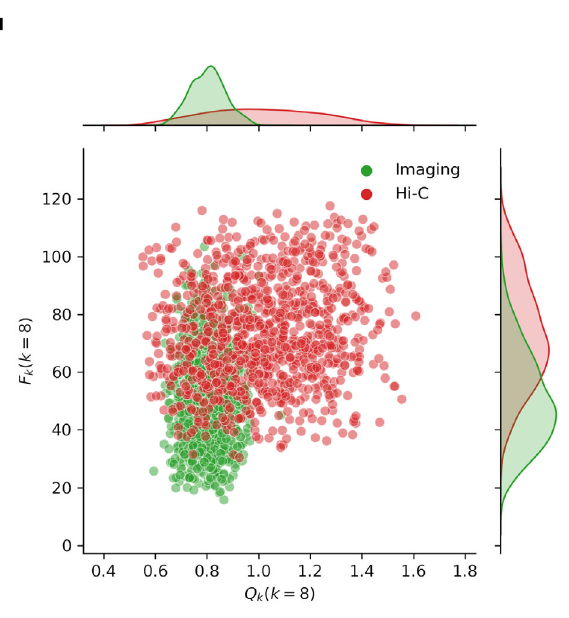
the resulting correlation matrix. d Scatter plot of Q k ( k =8) and F k ( k =8) for 1000 conformations. The conformations are randomly chosen from the total of ~3000 conformations measured in the imaging experiment (green). For Hi-C, 1000 con- formationsarerandomlygeneratedusingHIPPS/DIMES(red). e Histogramof k ij for A-A, B-B, and A-B. k ij s are obtained using Hi-C contact map. f Genomic-distance P N δ ð s (cid:2) ð j (cid:2) i ÞÞ k 〈 k 〉 are normalized h k ij ð s Þi = ð 1 = ð N (cid:2) s ÞÞ ij ( s ) ij forA-A, B-B,andA-B. i < j shown for s between 0 and 233 Mbp (left) and for between 0 and 10 Mbp